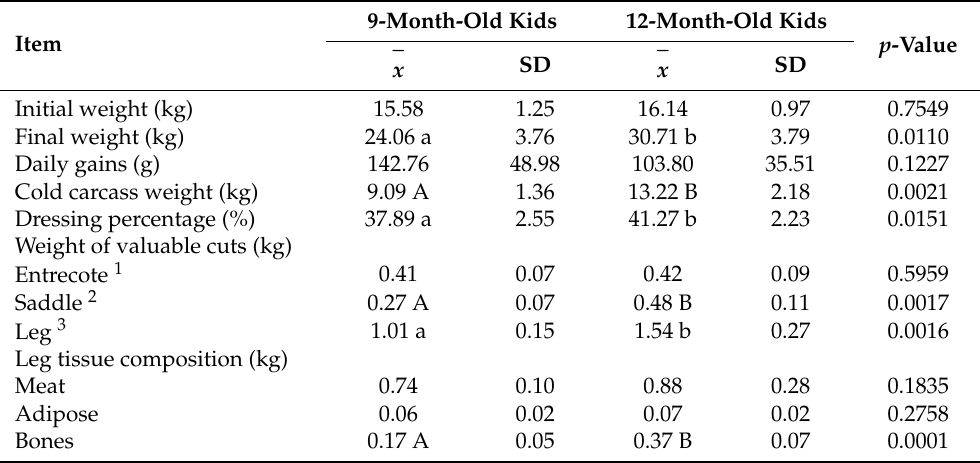
Table 1. Selected parameters of fattening and slaughter performance of